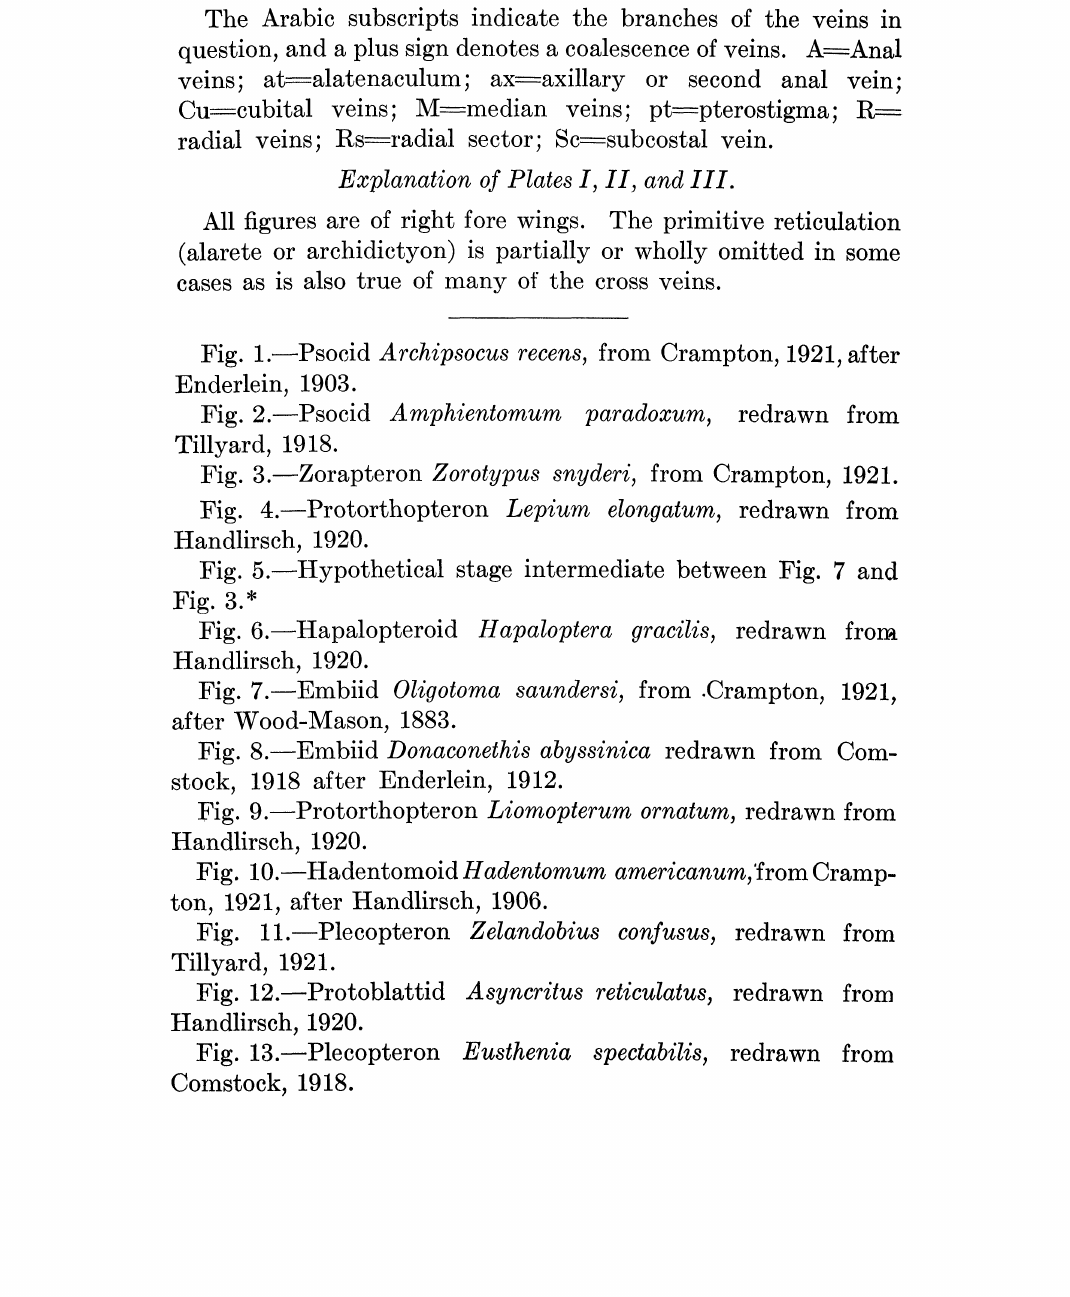
Fig. 2.--Psocid Amphientomum paradoxum, redrawn